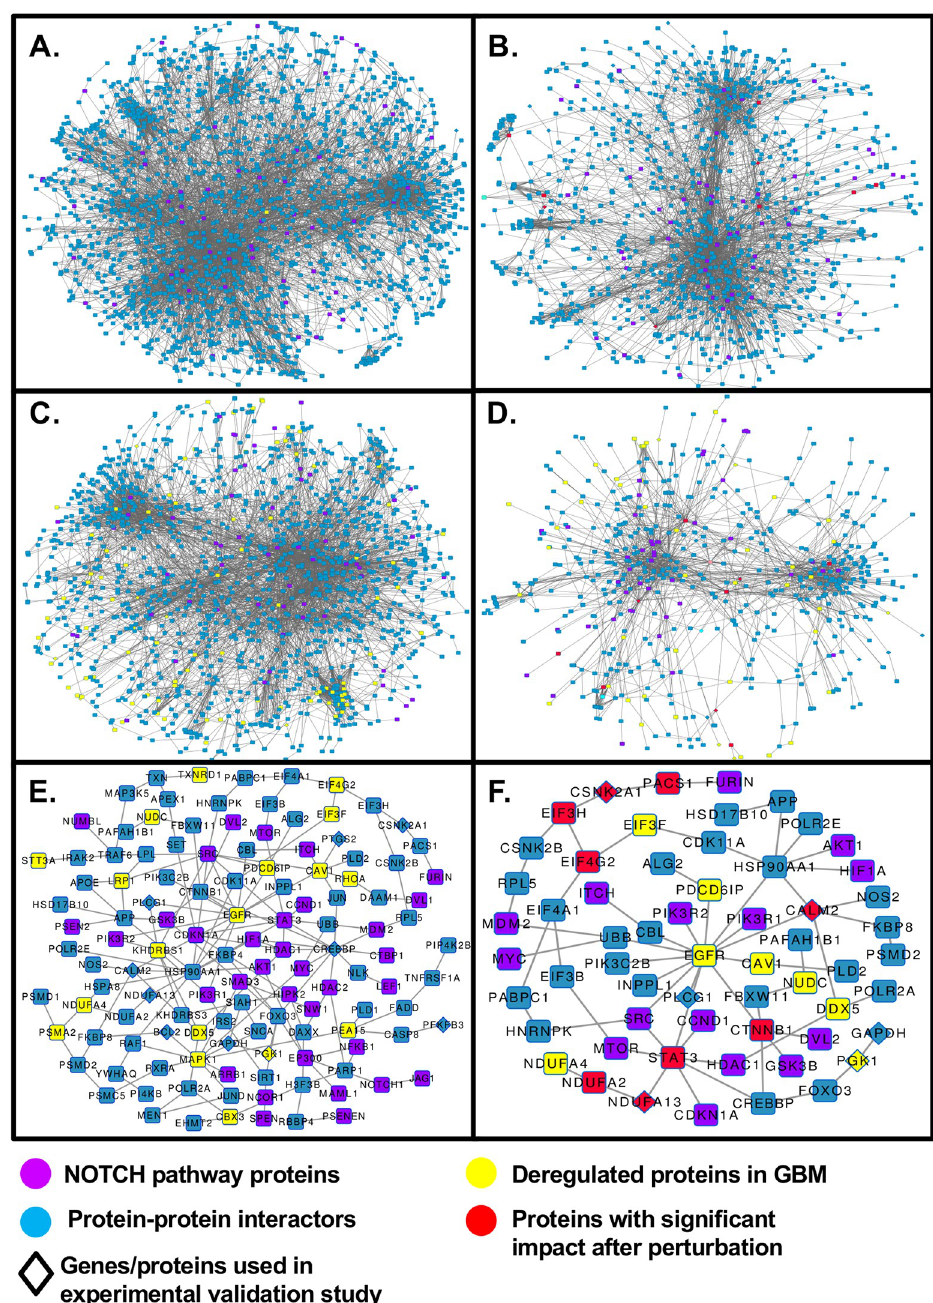
Fig 8. Enrichment of significant S-M interconnections by successive filtering during the development of the signaling-metabolic pathway network. The successive reduction of non-significant nodes and paths was followed for the inter-connection of the NOTCH pathway to all metabolic pathways. (A) Starting signaling-metabolic interaction network (SMIN) with the NOTCH pathway proteins in purple; (C) to GBM-specific network, and (E) the final GBM- specific significant (Z � 1) network. (B) Connections formed through twelve TOP Perturbation Impact (PI) nodes (red color) for NOTCH to all metabolic in SMIN; (D) connections formed through 11 nodes (in red color; out of 12 genes/ proteins found with significant perturbation impact [PI]) in GBM-specific network and (F) connections formed through 9 nodes (in red color; out of 12) in the GBM-specific significant (Z � 1) network.